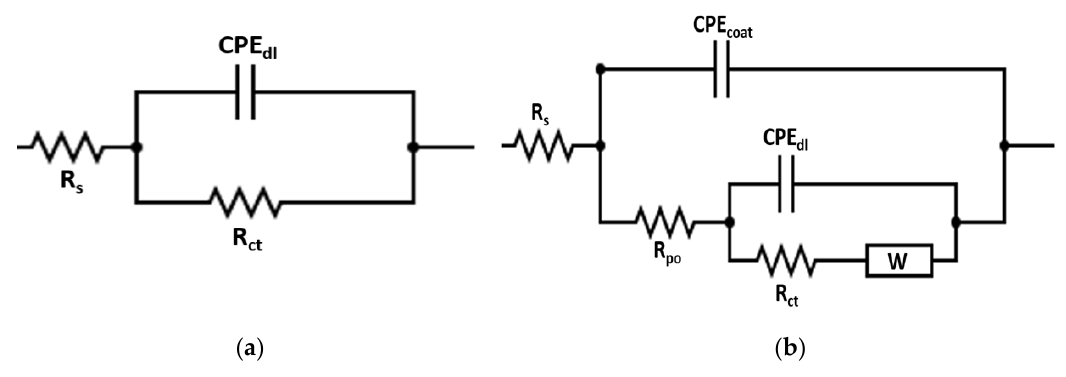
Figure 9. ( a ) One-time constant and ( b ) two–time constants equivalent electric circuits with a diffusion element. Table 5. Electrochemical impedance spectroscopy (EIS) fitting results of the HSLA steel NiP